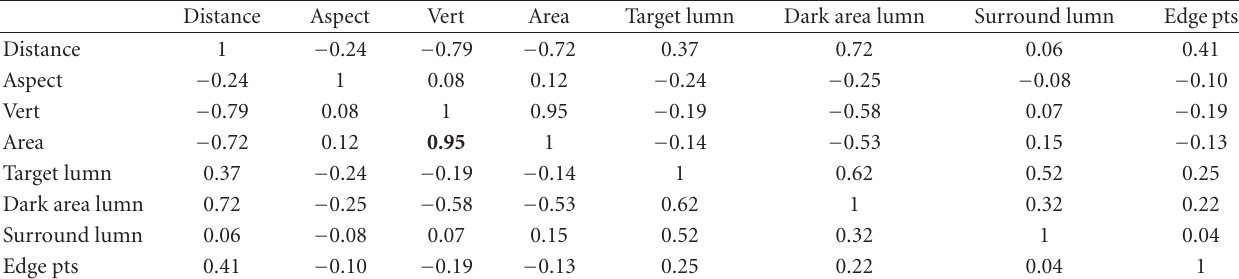
Table 4: Verimax analysis using MiniTab tool to calculate covariance between input vectors.